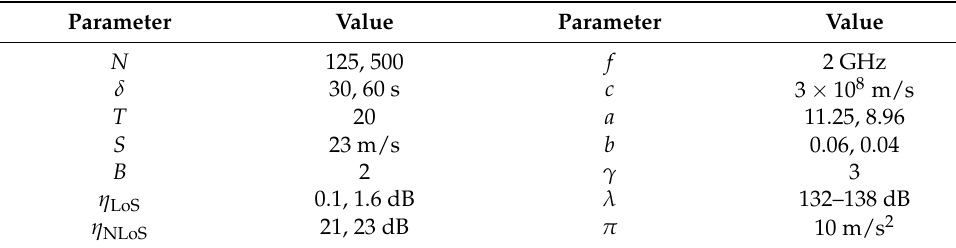
Figure 5. Sparse path loss map. Table 1. Simulation